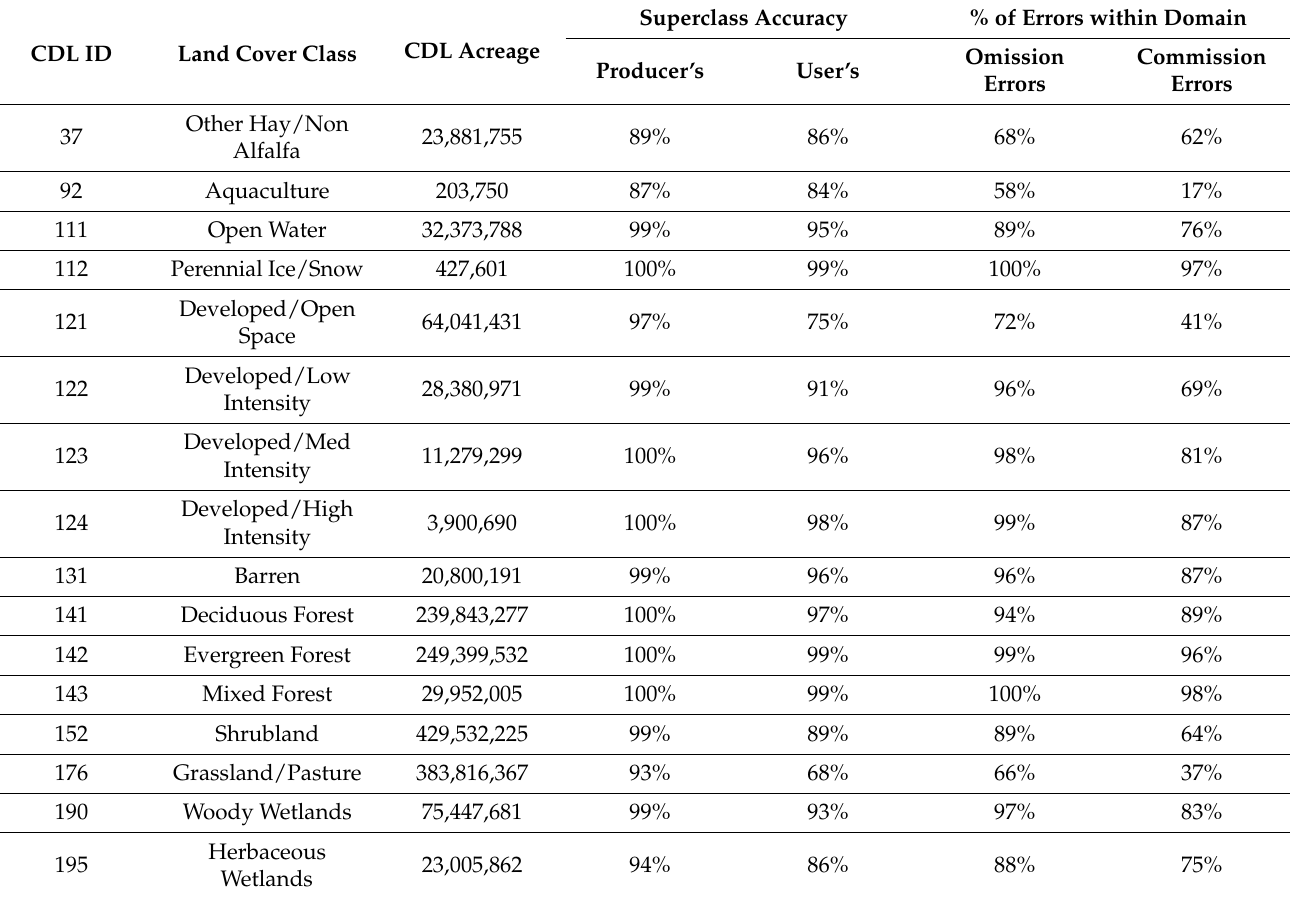
Table 5. Superclass producer and user accuracies for all 16 classes in the non-cropland domain in 2012. Superclass accuracy is the likelihood a given class is correctly identified as non-cropland. Percentage of errors within domain is the proportion of errors in the original CDL where the confusion occurs among two land covers within the non-cropland domain, rather than between a crop and non-cropland